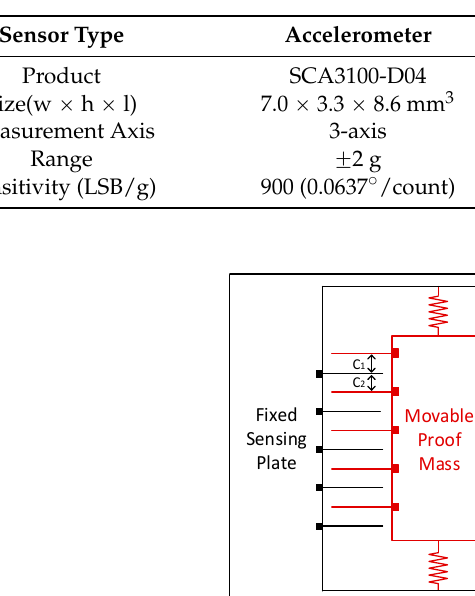
Table 1. Generic Data Sheet of the two Sensors Used in the Deployment.